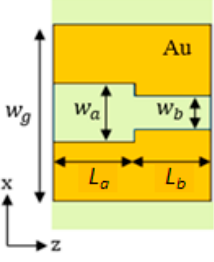
Figure 6. Top view of the Bragg grating unit cell.